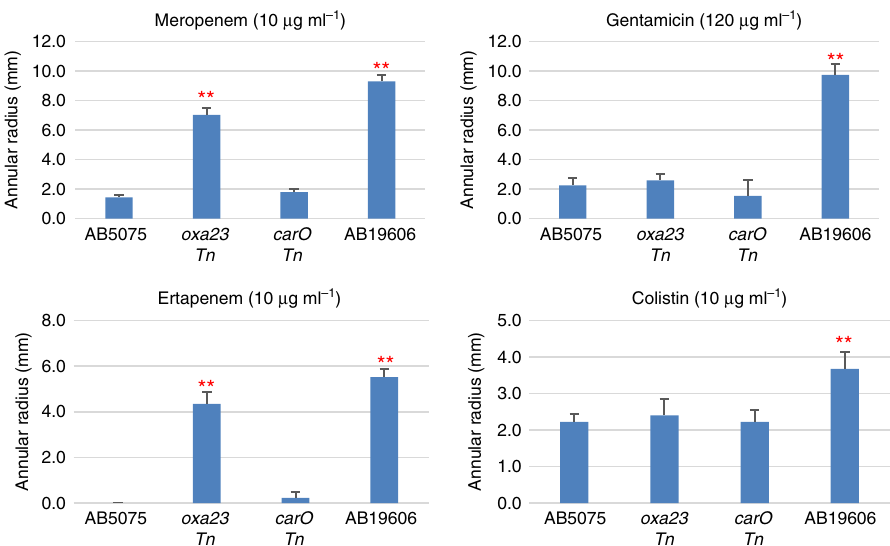
Figure 5 | Antibiotic sensitivity of AB5075 cells and transposon mutants examined with agar diffusion assays. The inhibition zone (annular radius) was measured after incubation at 37 (cid:2) C for 24h. Four individual isolates (biological replicates) were examined for each strain. Error bars indicate the s.d. of the four biological replicates. Asterisks indicate statistically significantly different from AB5075 WT (** P o 0.01, one-way unpaired analysis of variance, n ¼ 4). Meropenem and imipenem sensitivity measurements with MIC assays are shown in Table 1.